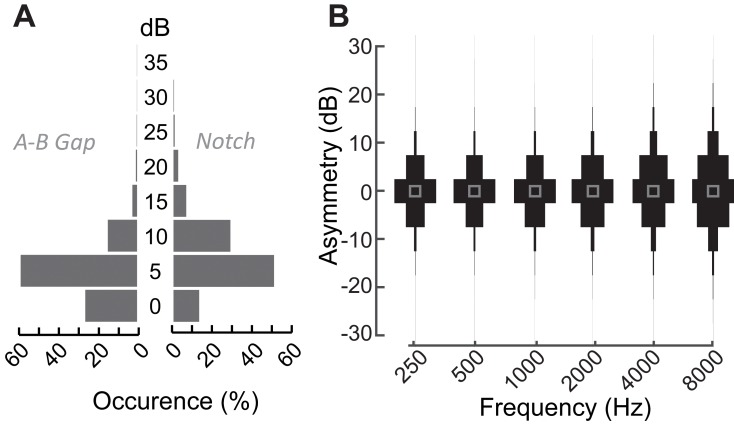
Audiometric characteristics of patients with normal audiograms that present at the Massachusetts Eye and Ear audiology clinic with complaints of poor hearing.(A) Distribution of air-bone gaps, that is differences in pure tone thresholds measured via air conduction and bone conduction suggests the absence of any conductive hearing loss in these patients with normal audiograms at any test frequency (left). These patients also did not exhibit large focal threshold shifts (notches) in the audiograms, which are indicative of significant noise damage (right) (Fausti et al., 1981; Mehrparvar et al., 2011; Le Prell et al., 2013) (B) Normalized distribution plots of the difference in hearing thresholds between the right and left ears at the various test frequencies indicate the lack of significant between-ear asymmetries. Hence by all clinical measures of hearing, these patients coming in to the clinic with hearing difficulties are considered to be audiometrically ‘normal’.